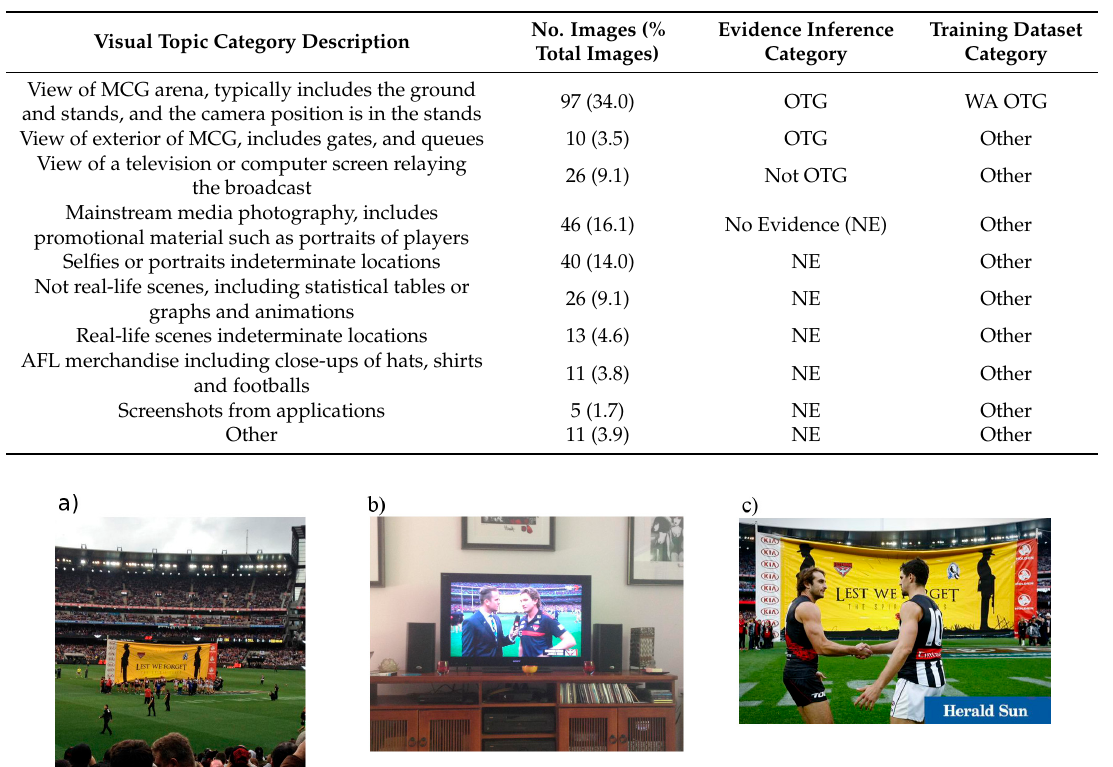
Table 4. The visual topic categories detected in the ADon dataset including their description, summary statistics, evidence inference category, and training dataset category for the binary classification.